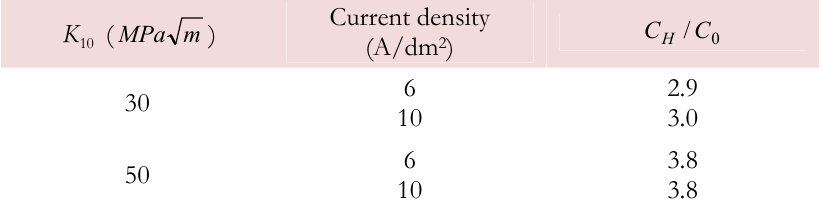
C of hydrogen ahead of the crack tip to the H